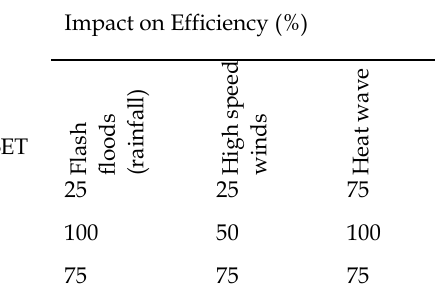
Table 8. Impact on selected operational assets at the container terminal